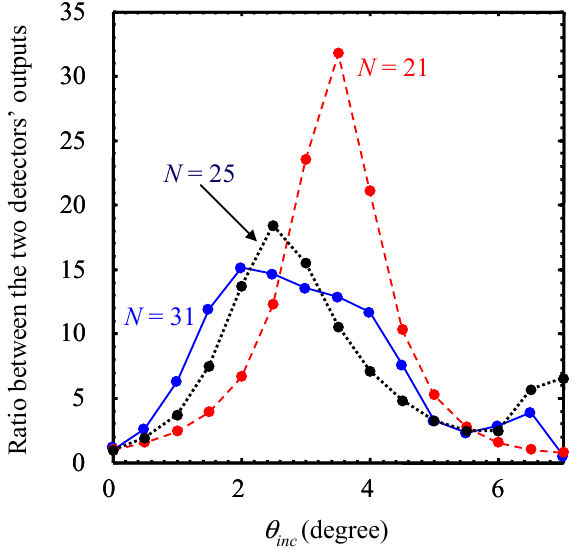
Figure 4. Numerical results for the angle detector with three different values of N